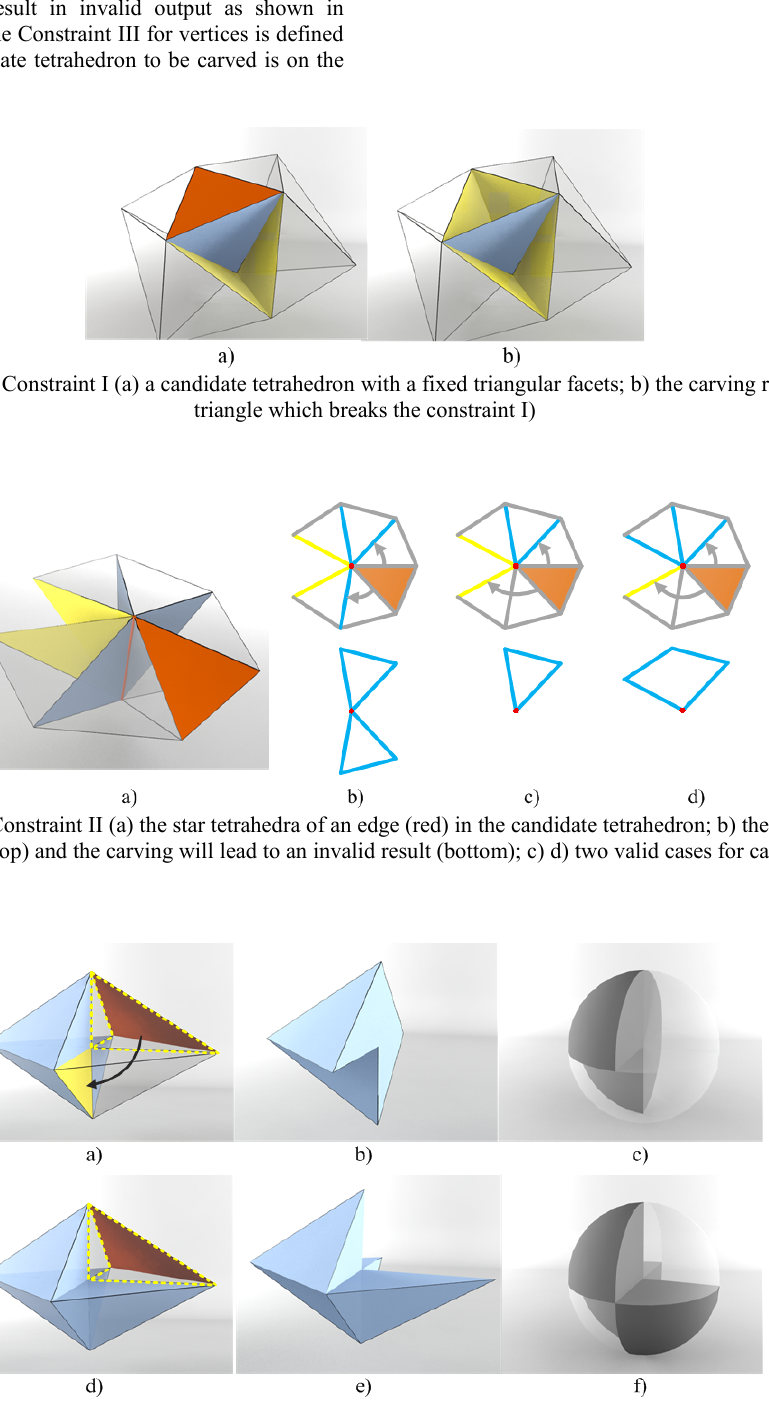
Figure 7. Illustration of Constraint III (a) the star tetrahedra of a vertex of a candidate tetrahedron, in which a path (black arrow) can be found from the candidate tetrahedron to the boundary shell (yellow); b) the possible result of carving of a); c) the sphere map of the center vertex of b); d) another case of the star tetrahedra of the vertex, in which all paths from the candidate tetrahedron to the boundary shell are blocked by the fixed tetrhedra; e) the possible result of carving of d); f) the sphere map of the center vertex of